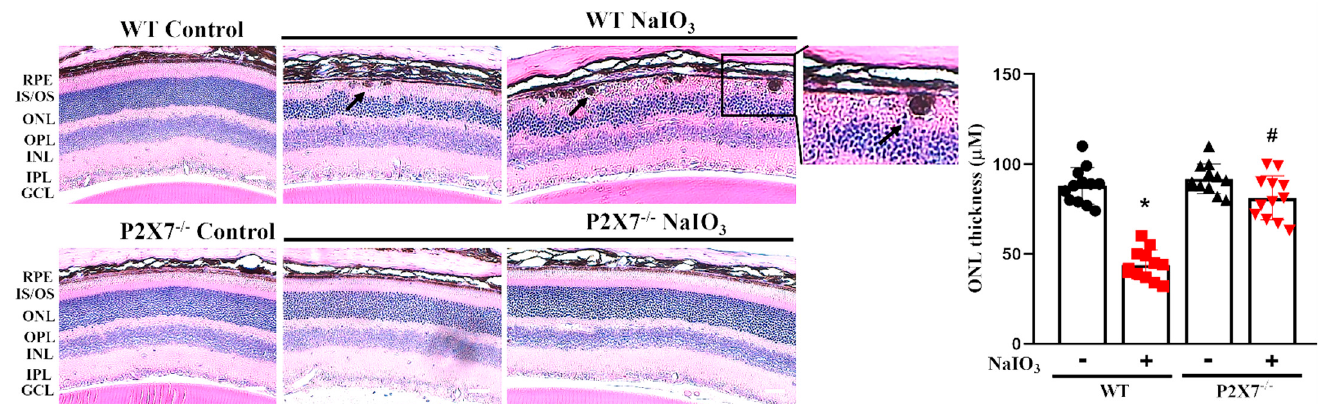
Figure 3. Histological H&E examination of retinal injury caused by NaIO 3 was alleviated in P2X7 − / − mice. Retinal morphology and loss of photoreceptors and cell nuclei were evaluated by H&E by light microscopy at 3 days post-intraperitoneal injection of NaIO 3 (25 mg/kg) in WT and P2X7 − / − mice. Shown were representative light microscopic images of H&E staining in retinal sections. Enlargement of cell bodies in the ONL and INL, pigment granules along the RPE layer (black arrows) and ONL thinning were observed. Quantitative analysis of ONL thickness was shown. The mice number was 12 for each group. Scale bar: 200 μ m. * p < 0.05, indicating significant decrease in ONL thickness